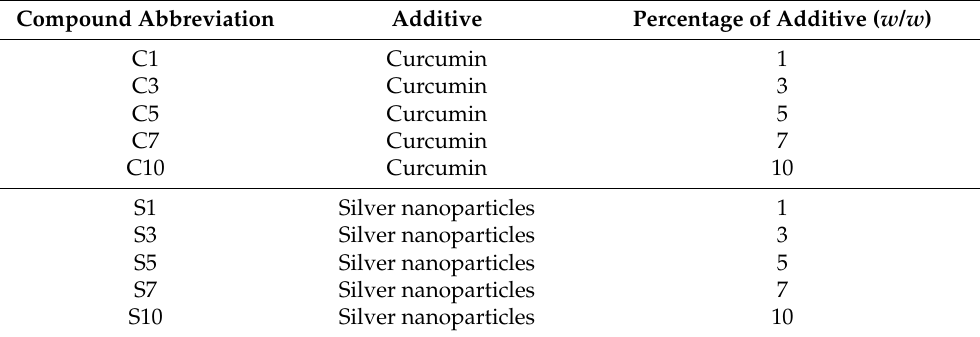
Table 2. Compound abbreviations according to the dye and weight percentage.